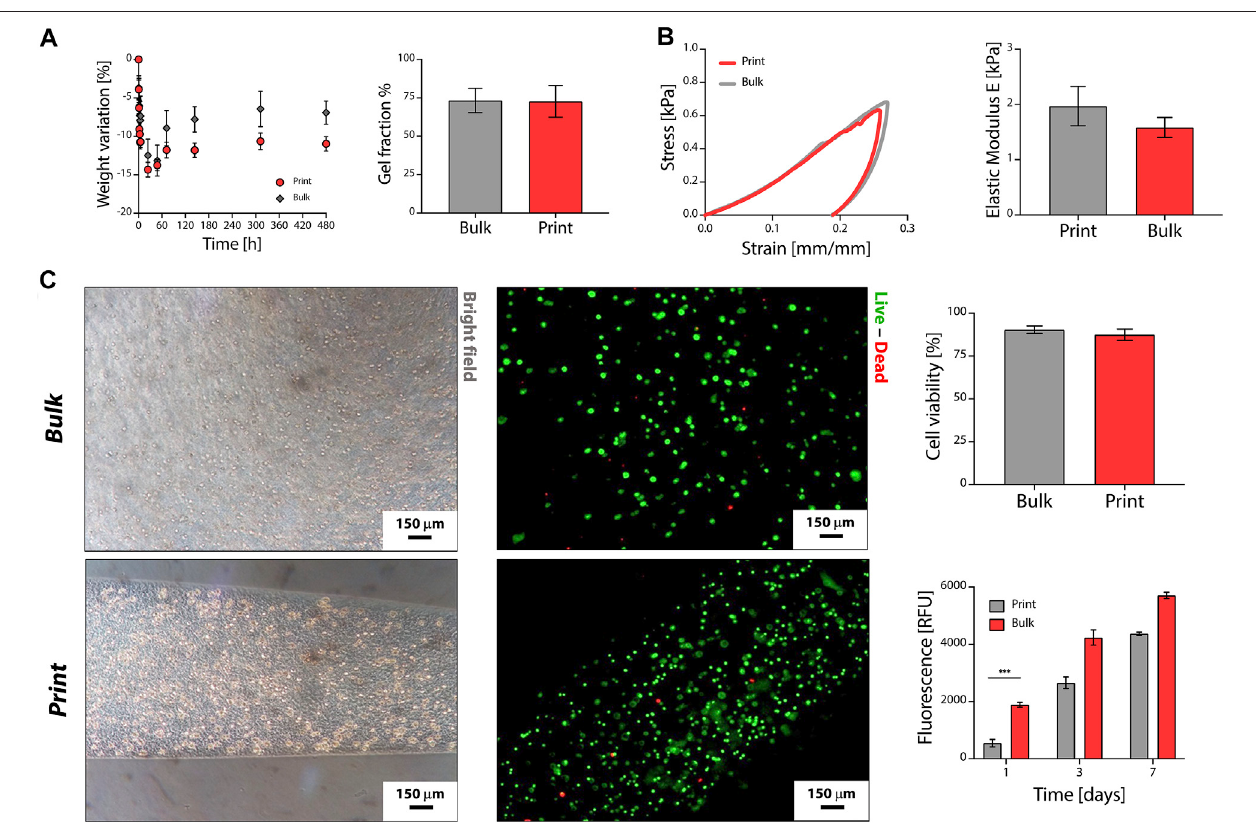
FIGURE3| Pectin-TOCNFsbioprinting. (A) Weightvariation (left) andsolidgelfraction (right) oftheprintedandbulkmulticomponenthydrogels. (B) Compressive mechanical properties. Representative stress – strain curves (left) and elastic modulus E (right) of printed and bulk hydrogels. (C) In vitro cytocompatibility tests and bioprinting. Live/dead staining of cells embedded in bulk and printed hydrogels (left) and percentage cell viability (top right) . Metabolic activity, tested by alamarBlue ® assay, of cells cultured in bulk and printed hydrogels (bottom right) ; *** p < 0.001.